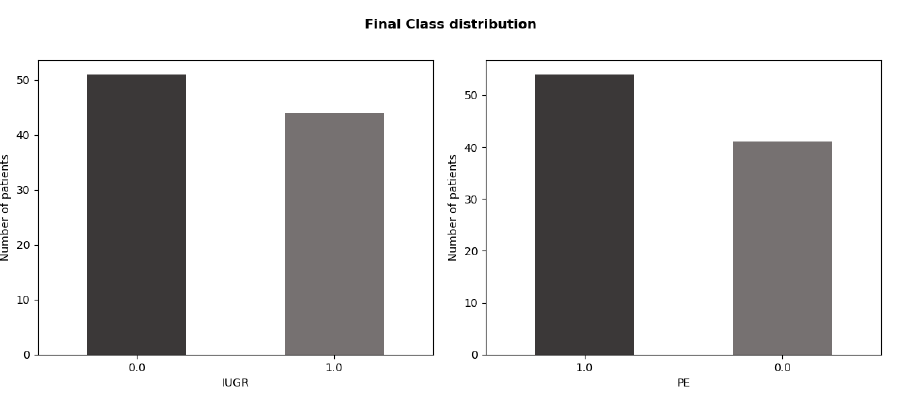
Figure 2. Final distribution of the target variable. The class was transform into two binary label: PE and IURG. The distribution of each label is more balanced than the initial class